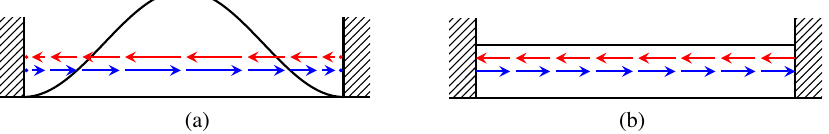
FIG. 9. Quasiparticle picture: In both (a) and (b), black lines are the cartoon profile for the Hamiltonians, and the red (blue) arrows are the corresponding velocities for the left- (right-) moving quasiparticles. (a) SSD Hamiltonian and (b) Uniform